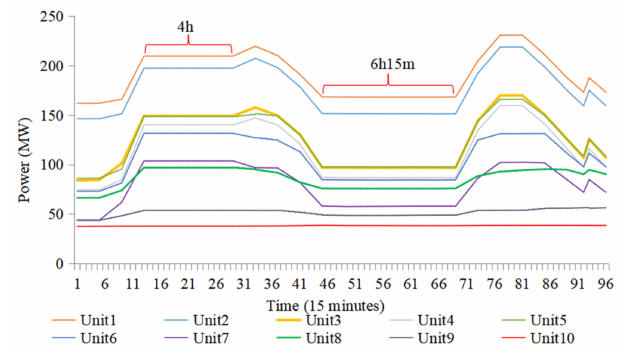
Figure 21. The power outputs of thermal generators in Case 4. Table 5. Comparison of Case 3 and Case 4